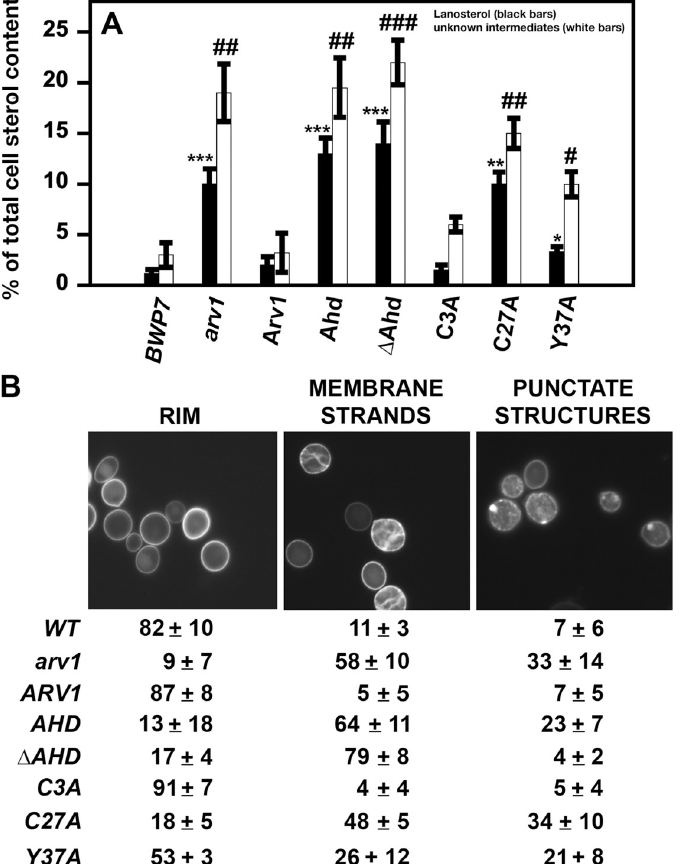
Fig 3. Scarv1 expressing ScArv1 C27A and ScArv1 Y37A are unable to maintain proper sterol composition and localization. (A) Sterol composition and localization was determined in Scarv1 cells expressing ScArv1 mutants. Sterol composition was determined by LC/MS as described in Materials and Methods. Sterol levels were plotted as a percentage of total cellular sterol content. Data represent the percentages of lanosterol ( black bars ) and unknown sterol intermediates ( white bars ). (B) The localization of unesterified sterol was visualized using filipin staining and fluorescence microscopy. Values are the percentage of cells with the indicated structures. The data are representative of 5 individual double-blinded experiments. 300–500 cells were analyzed for each individual experiment. � p � 0 . 01 ; �� p � 0 . 001 ; ��� p � 0 . 0001 ; ## p � 0 . 01 ; ## p � 0 . 001 ; ### p � 0 . 0001